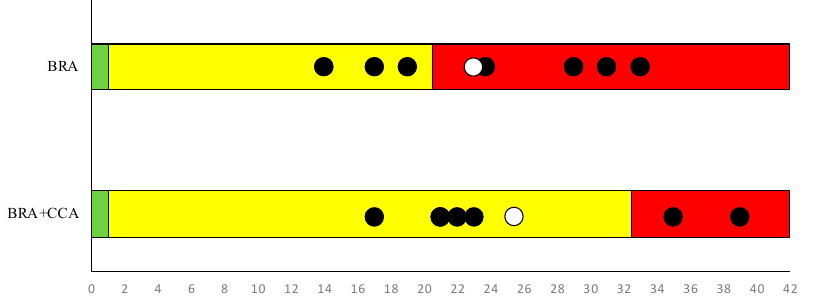
Figure 5. Results of AS ‐ ISK for BRA and BRA + CCA conducted by seven assessors. The black dots are the single assessments and the white dots are the average values for all assessors. In BRA + CCA, two dots present the same value (21). The colour inside each column represents the invasiveness risk: green (value less than 1) is low risk; yellow corresponds to medium risk, and red corresponds to high risk. The threshold values between medium and high risk are in accordance with the species (marine fish) and the ecoregion (temperate marine) analysed